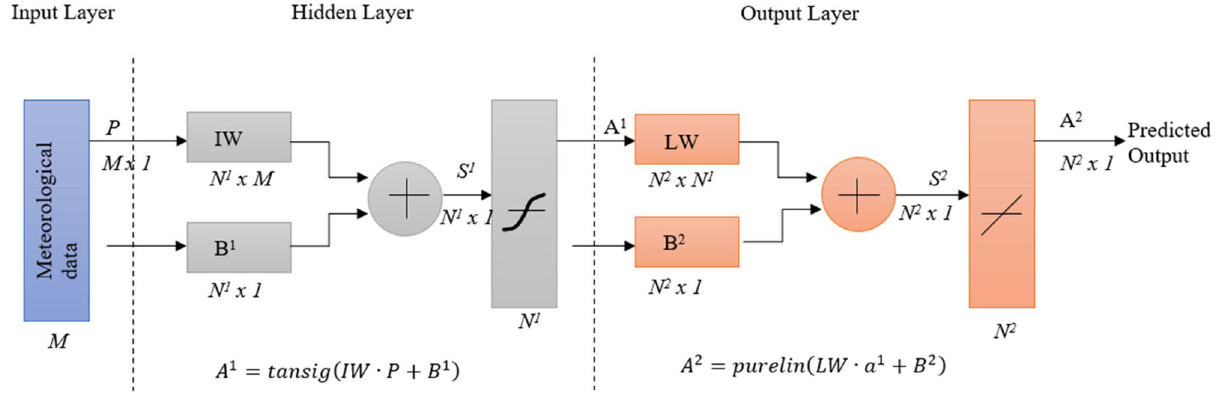
Figure 2. Architecture of